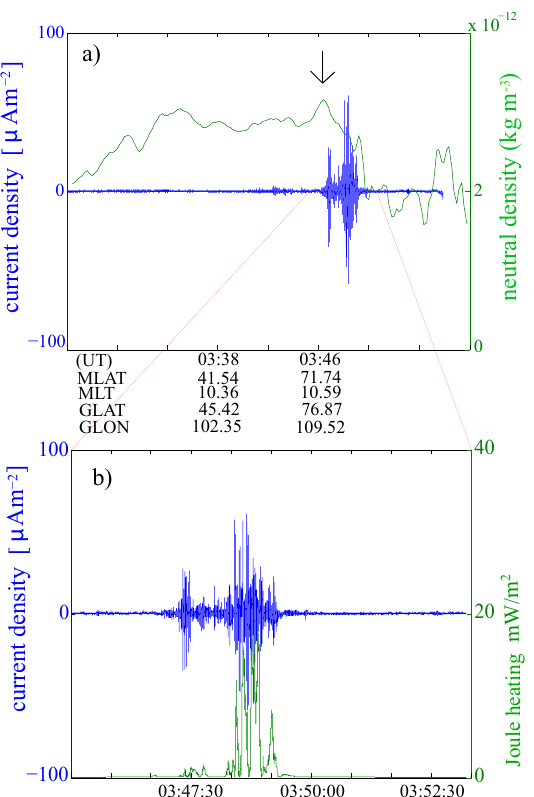
Figure 11. Cluster 3 on 9 June 2008: (a) electron spectrogram, (b) pitch angle distribution of electrons, (c) ion spectrogram, (d) ion velocity in GSE, (e) ion density, (f) parallel (to mag. field) temper- ature. Two violet lines mark the cusp